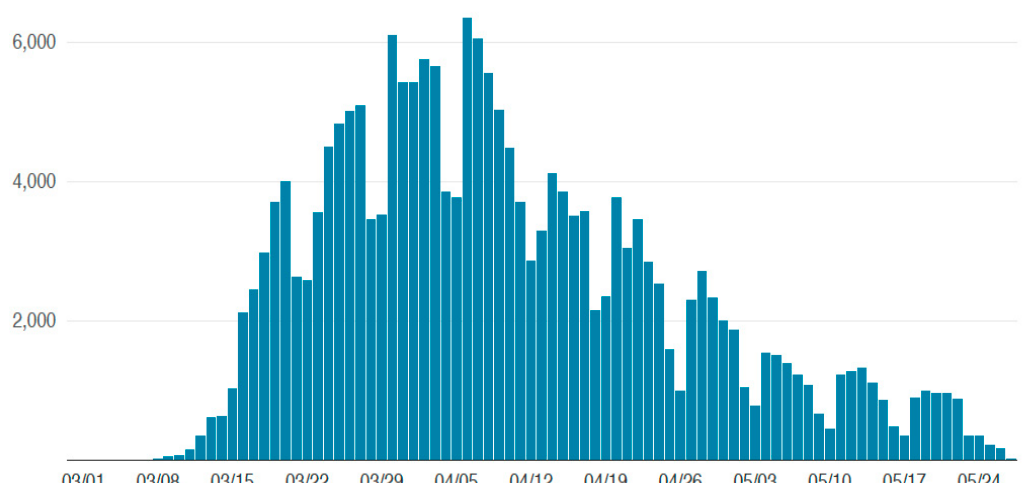
Figure 4. These approximately 7-day periodic peaks and troughs in the infection rate show clear minima occurring every weekend and broad peaks in the week (Source: data for New York City accessed at www1.nyc.gov / site / doh / covid /